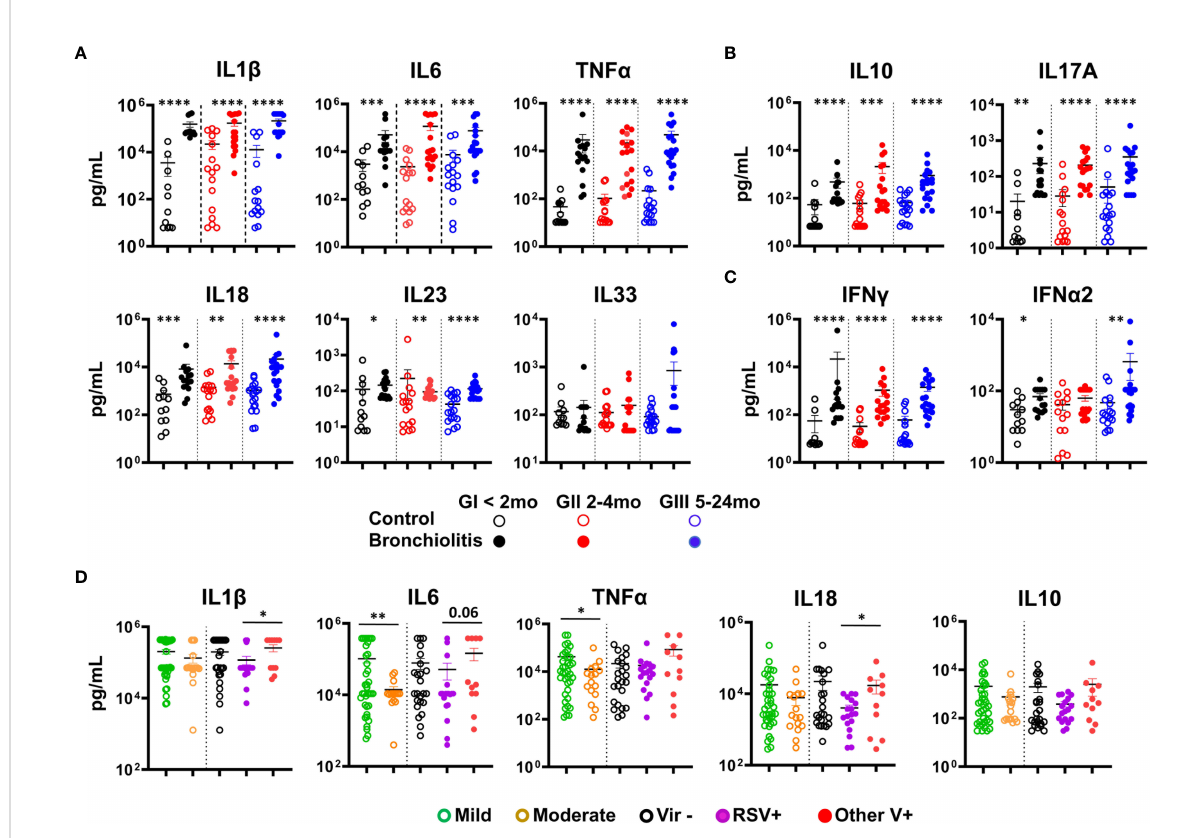
FIGURE 2 Bronchiolitis NLF samples contain elevated levels of cytokines. Cytometric bead array (CBA) determination of a panel of cytokines in the NLF supernatants from controls and bronchiolitis patients: GI (controls n = 12, bronchiolitis n = 16), GII (controls n = 16, bronchiolitis n = 18), and GIII (controls n = 18 bronchiolitis n =19). The scatter dot plots represent the individual values, and the mean ± SEM is depicted for each group. Statistical analyses were performed using non-parametric Mann-Whitney sum rank test or the unpaired t-test with Welch´s correction. (A) Quanti fi cation of the pro-in fl ammatory cytokines IL1 b , IL6, TNF a , IL18, IL23 and IL33. (B) Determination of IL10 and IL17A, and (C) IFN g and IFN a 2. (D) Analysis of IL1 b , IL6, TNF a , IL18 and IL10 in samples according to the severity of bronchiolitis (based on the Tal modi fi ed score), mild (n = 37) or moderate (n = 16) and the presence/absence of respiratory viruses: absence of virus, (Vir-, n = 24), presence of RSV (RSV+, 15 RSV alone and 3 coinfections, n = 18), presence of other virus (OtherV+, n = 11, including 9 single infections and 2 coinfections without RSV). *p < 0.05; **p < 0.01; ***p < 0.001; ****p <